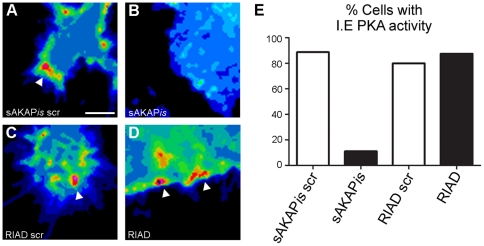
Invading edge PKA activity is mediated by RII-AKAP interactions.(A-D) SKOV-3 cells co-expressing the indicated plasmids in conjunction with pmAKAR3 were subject to the donut invasion assay for 18 hr and imaged via FRET microscopy. Representative pseudocolored FRET images of cells co-expressing mCherry fused to (A) scrambled superAKAPis (sAKAPis scr), (B) superAKAPis (sAKAPis), (C) scrambled RIAD (RIAD scr), or (D) RIAD are shown. White arrowheads point to leading edge PKA activity (scale bar  = 10 µm). (E) The results, as the percentages of cells exhibiting PKA activity at the invasive edge (I.E.), were tabulated as in Figure 4 (n = 21 from three separate experiments).